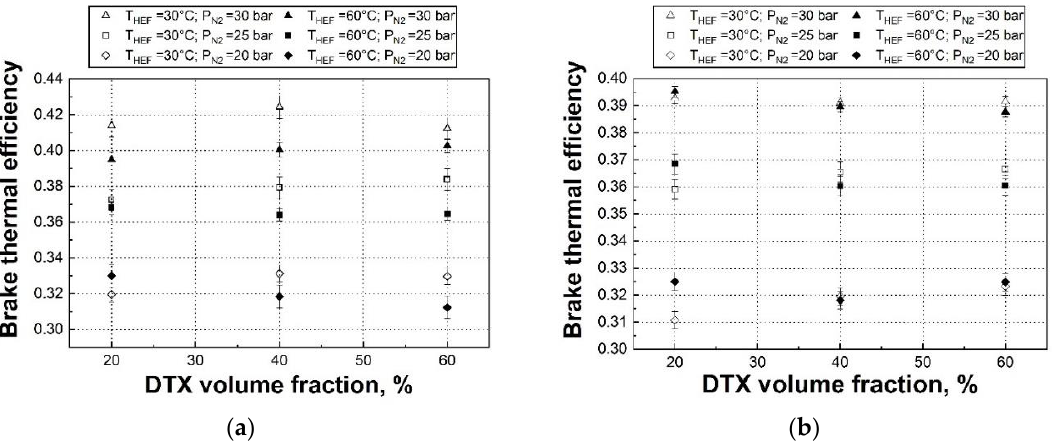
Figure 11. Brake thermal efficiencies at different engine speeds: ( a ) 𝑁 = 600 rpm and ( b ) 𝑁 = 700 rpm. Another useful parameter to quantify nitrogen consumption is the Brake Specific Nitrogen Consumption ( BSNC ) which is plotted in Figure 12. Compared to brake power values, an opposite but weaker trend was found in the effect of variations in DTX volume fractions on the BSNC. This suggests that the brake power had a marginally more important role compared to the nitrogen flow rate in calculations of the BSNC. More